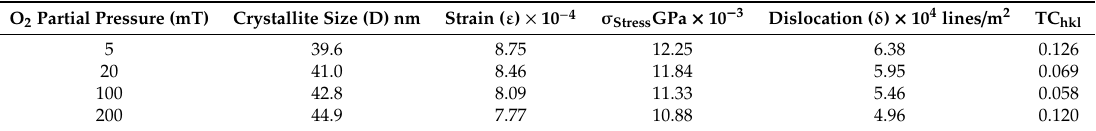
Table 2. Structural parameters for the Bi 2 O 3 :Ho 3 + (1 mol.%) films obtained at di ff erent O 2 partial pressures with constant substrate temperature at 400 ◦